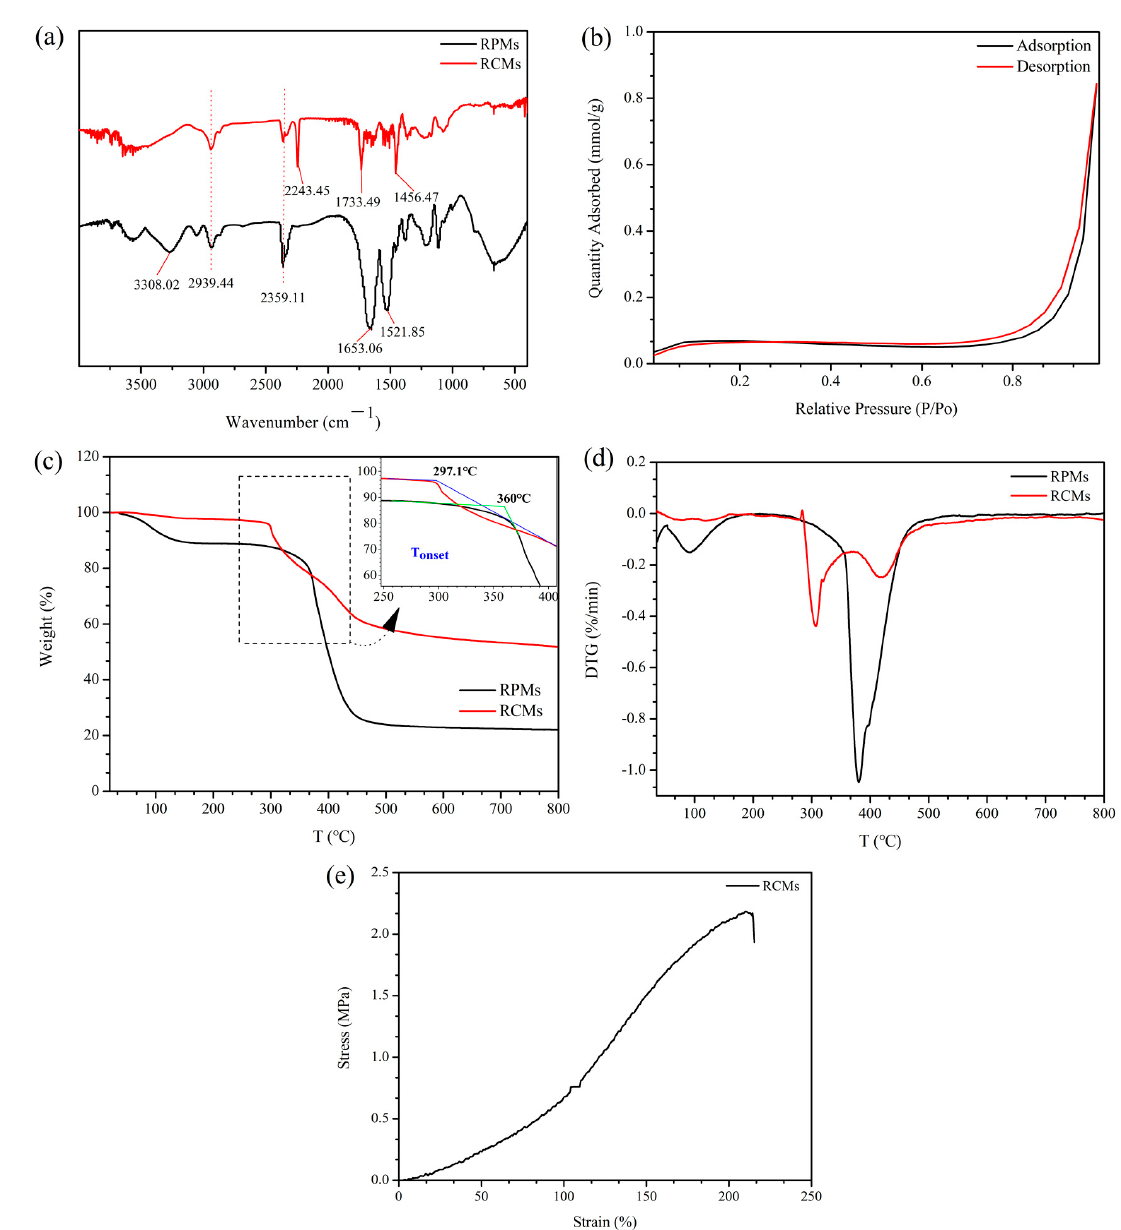
Figure 3. ( a ) FI-IR images of RCMs and RPMs; ( b ) N 2 adsorption–desorption of RPMs; ( c ) TGA of RCMs and RPMs; ( d ) DTG of RCMs and RPMs ( e ) Stress − strain curves of RCMs.